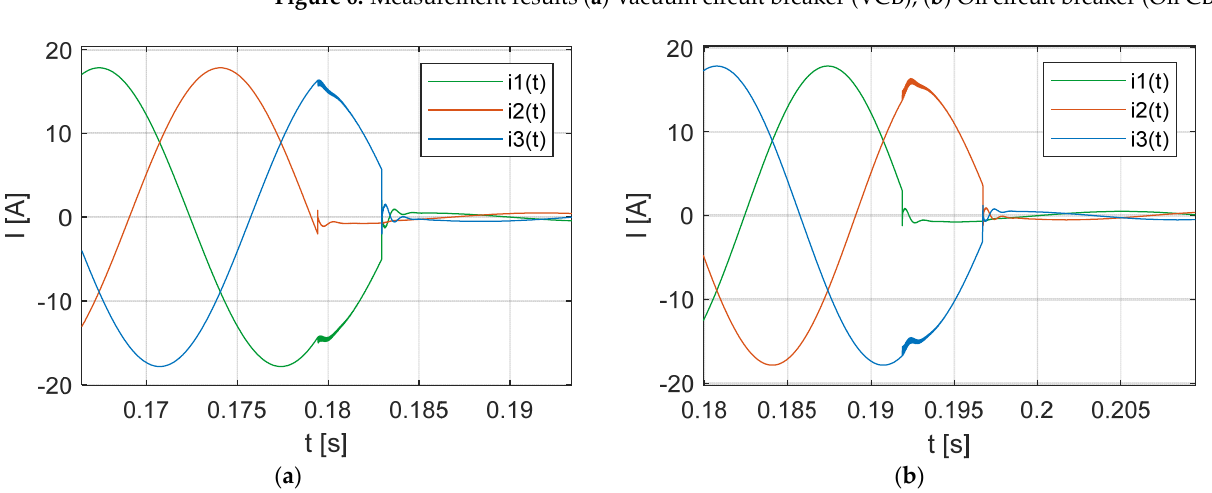
( b ) Figure 8. Simulation results (Clark transformation) ( a ) VCB; ( b ) Oil CB. Source: own calculations.